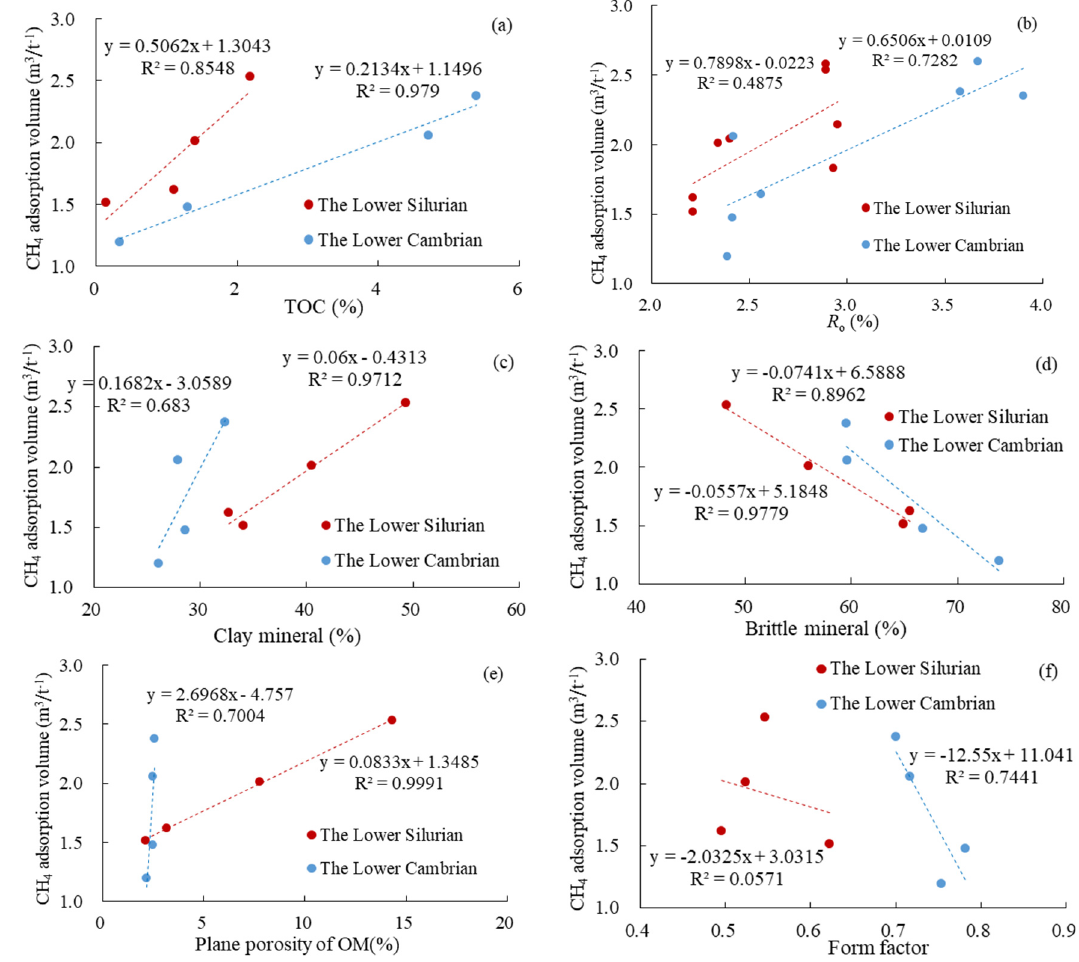
Figure 19. Relationship between CH 4 adsorption volume and TOC ( a ), R o ( b ), clay mineral ( c ), brittle mineral ( d ), plane porosity of OM ( e ), form factor ( f ) of the Lower Paleozoic shale from the upper Yangtze Plate.